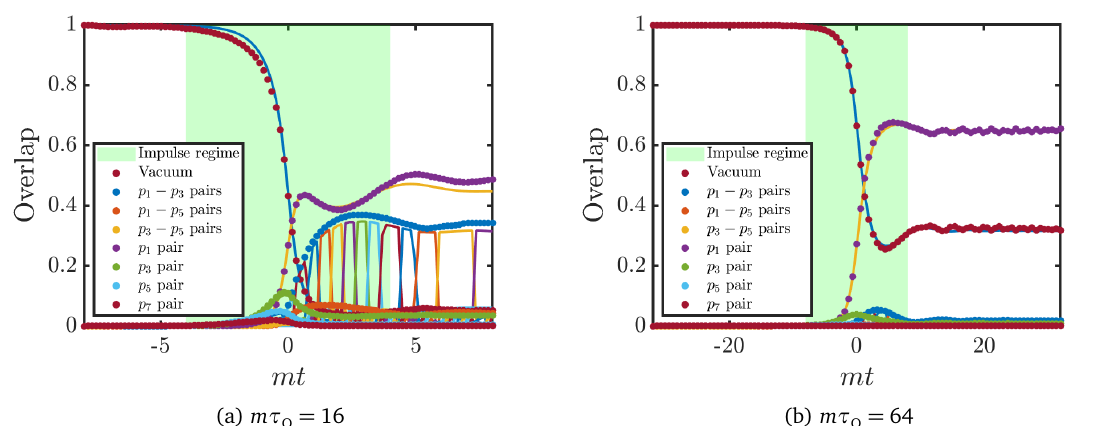
Figure 3.1: Overlaps of the evolving wave function with instantaneous eigenstates for two different ramps from the paramagnetic to the ferromagnetic phase with = 16 and m τ = 64 for mL = 50 ( m = M m τ in terms of the initial mass). Q Q i The green region indicates the non-adiabatic regime. Solid lines are TCSA data for = 25 while dots are obtained from the numerical solution of the exact differen- N cut tial equations. Analytical results are plotted only for the few low-momentum states with the most substantial overlap. Lower indices in the legends refer to the quantum = n π/ L . The com- numbers of the modes present in the many-body eigenstate: p n posite structure of some lines is caused by level crossings experienced by multiparticle